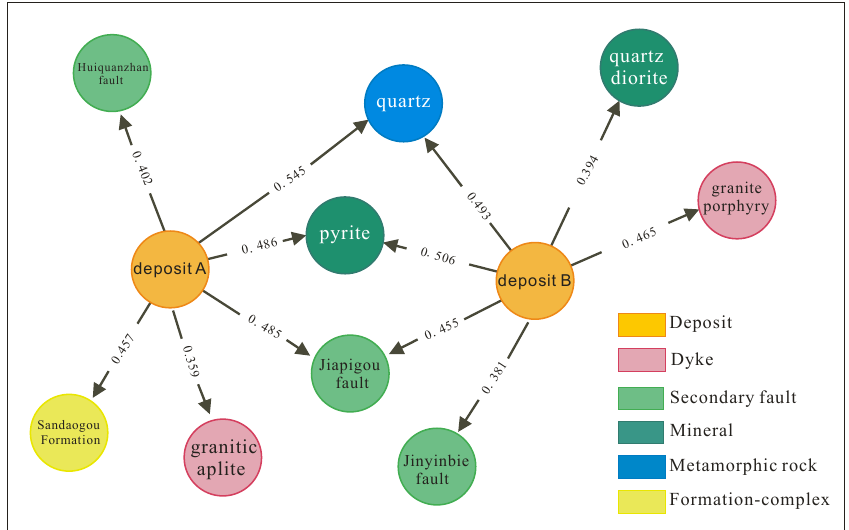
Figure 7. The relationship between the deposits and geological entities.